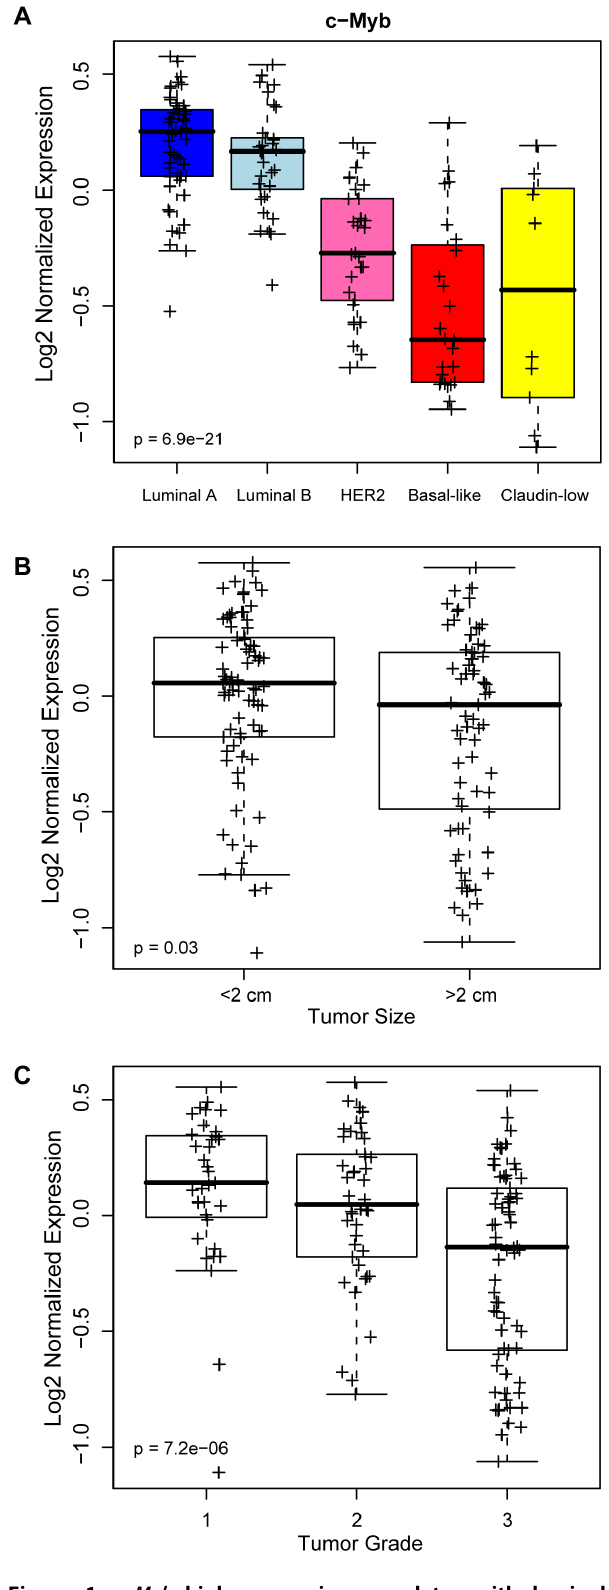
Figure 1. c-Myb high expression correlates with luminal subtype, small tumor size and low tumor grade breast cancers. (A) c-Myb expression varied across breast tumor subtypes in the NKI local-only treated tumor dataset (n=147). The relationship of c-Myb